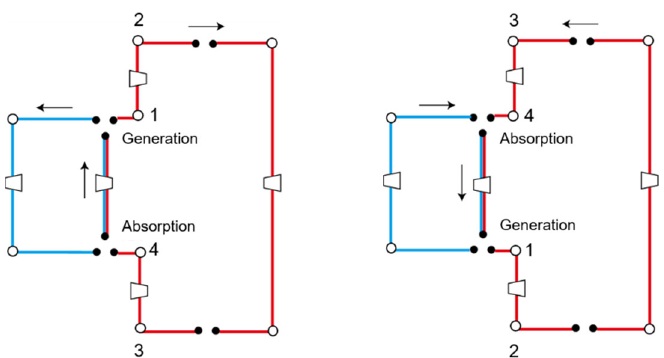
Figure 2. Examples of the basic configuration for the absorption system that is obtained by assembling two elementary cycles, in which each elementary cycle shares a part of compression(left)/expansion(right) process. (red line—refrigerant, blue line—absorbent solution).